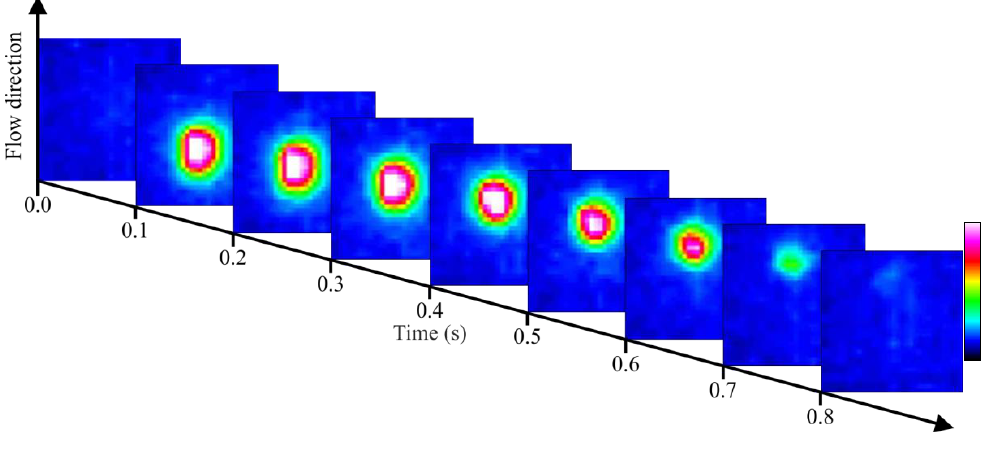
Figure 7. Flow of one air bubble through the static crude oil.